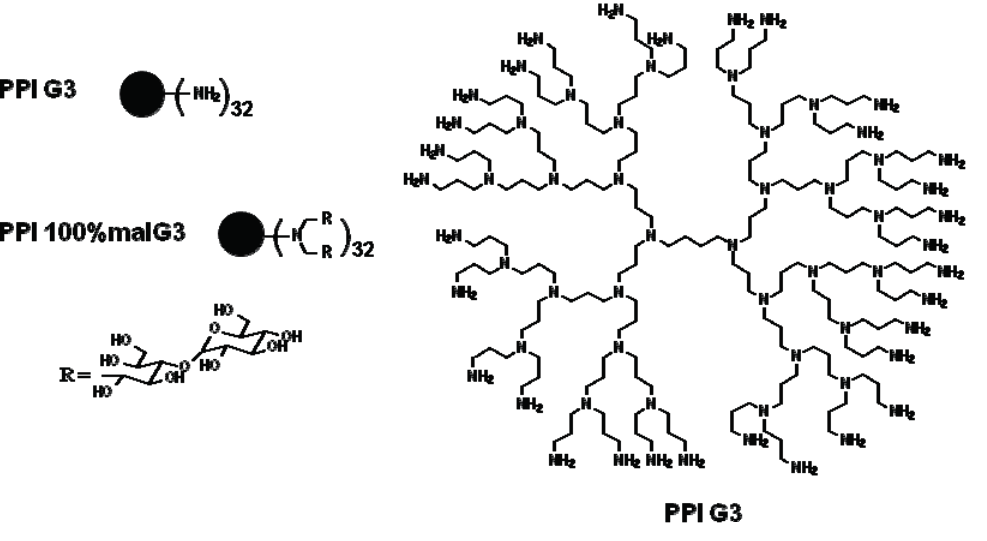
Figure 1. Structures of PPI G3 dendrimers unmodified (PPI) and modified with maltose in 100% (PPI